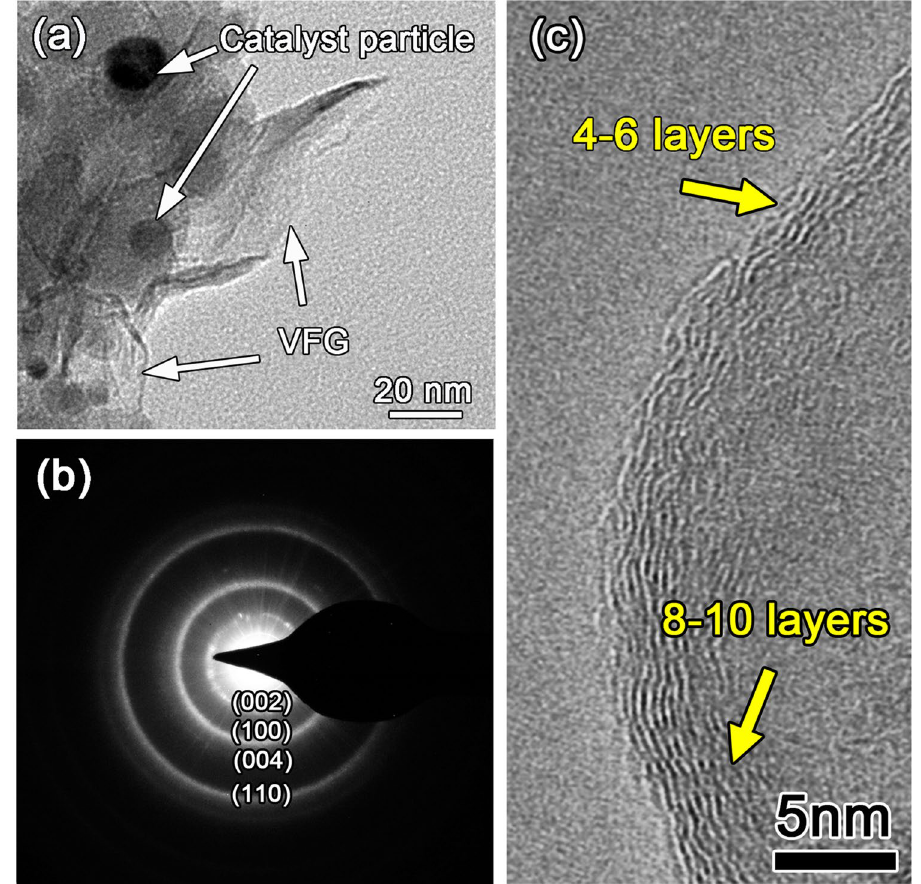
Figure 2. Characterization of the VFG. ( a ) TEM images of the VFG and the catalyst particles. The VFG was directly scratched from the surface of the SiO 2f /SiO 2 composite with VFG decoration. A carbon coated micro-grid was adopted to support the VFG. ( b ) Corresponding SAED pattern of the VFG. ( c ) Corresponding HRTEM image of the VFG.